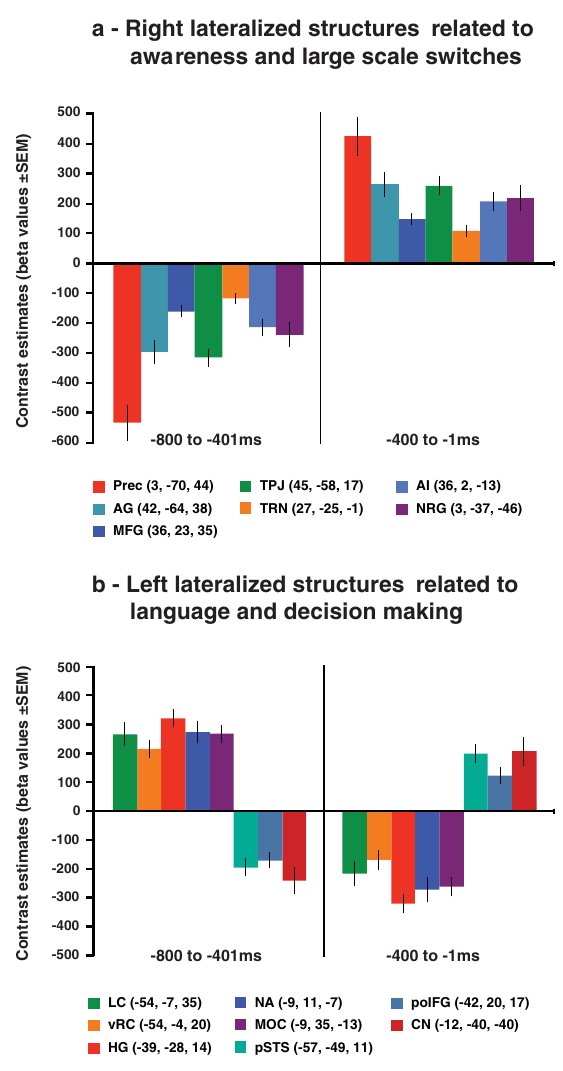
Figure 5. Experiment 1 contrast estimates in pre-RT epochs. Abbreviations: ( a ) AG , angular gyrus; AI , anterior insula; MFG , middle frontal gyrus; NRG , nucleus reticularis gigantocellularis; Prec , precuneus; TPJ , temporoparietal junction; TRN , thalamic reticular nucleus; ( b) CN , cochlear nucleus; HG , Heschl’s gyrus; LC , laryngeal cortex; MOC , medial orbital cortex; NA , nucleus accumbens; poIFG , pars opercularis inferior frontal gyrus; pSTS , posterior superior temporal sulcus; vRC , ventral Rolandic